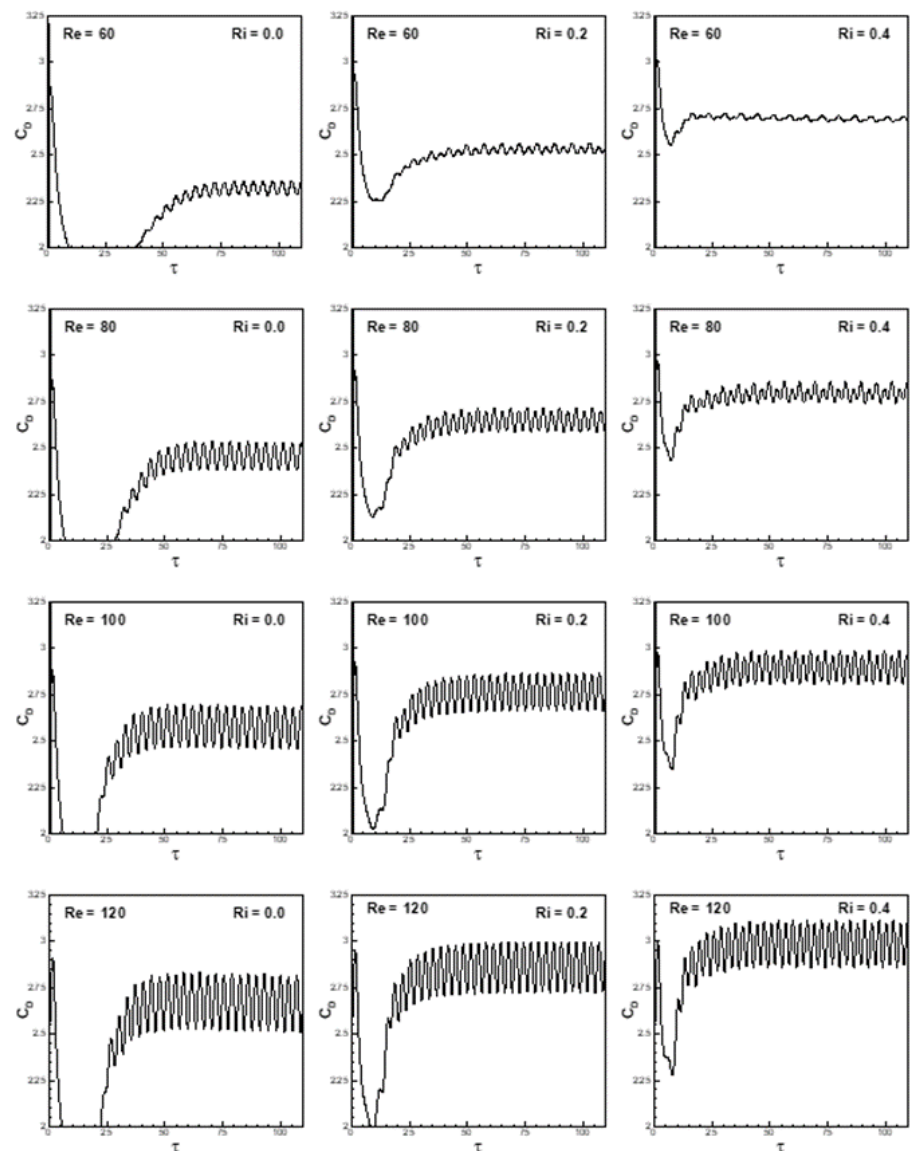
Figure 21. Variation of coefficient of drag with non-dimensional time for the conditions ( α = 45 ◦ , 0 ≤ Ri ≤ 0.4 and 60 ≤ Re ≤ 120).